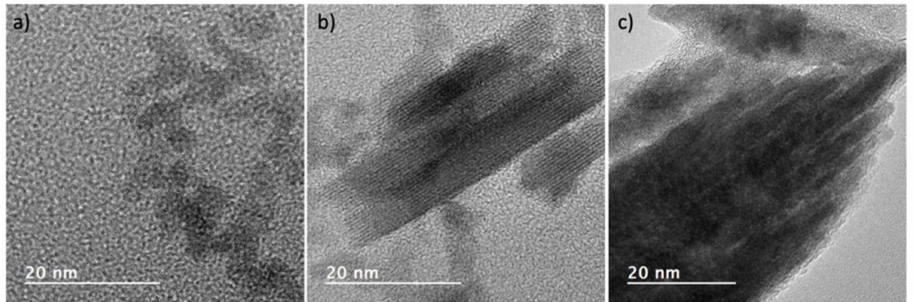
Figure 9. Transmission electron bright field micrographs showing the d-spacing of ( a ) 5, ( b ) 50 and ( c ) 100 nm